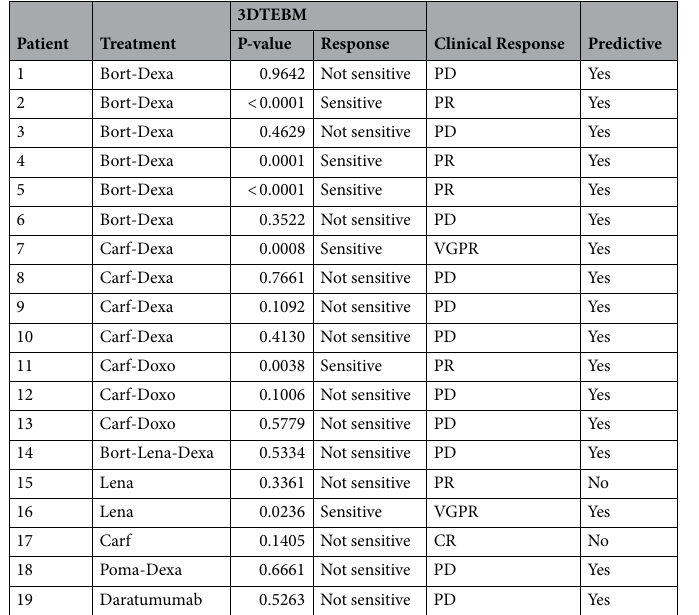
Table 3. Clinical responses and predictability of